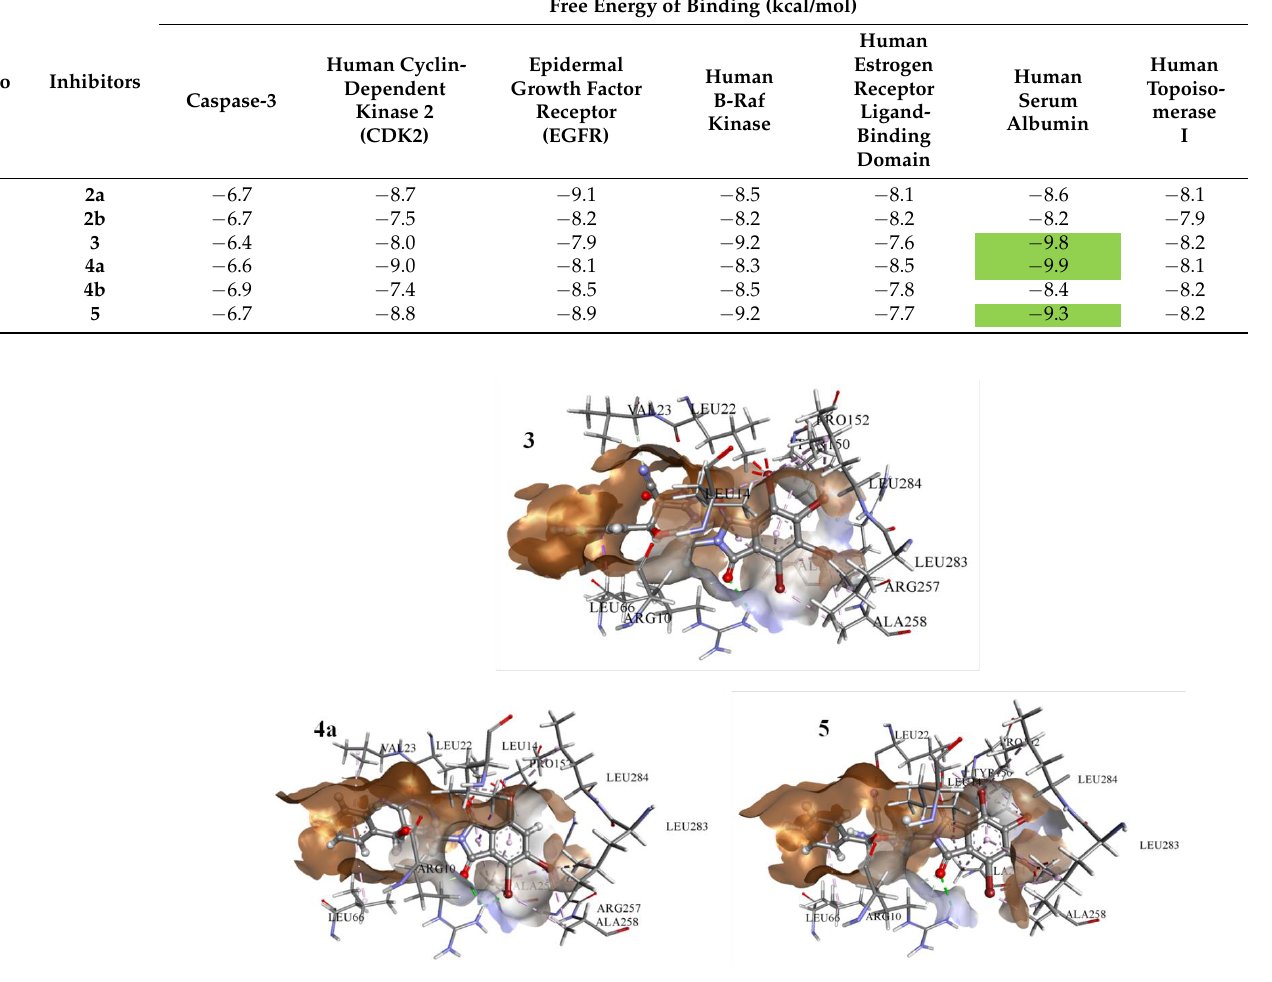
Figure 8. The result from docked complexes of HSA and studied inhibitors 3 , 4a , and 5 . Table 12. List of virtual screening-based parameters for the selected drug targets against the studied anticancer inhibitors (green color selected for MD simulations).